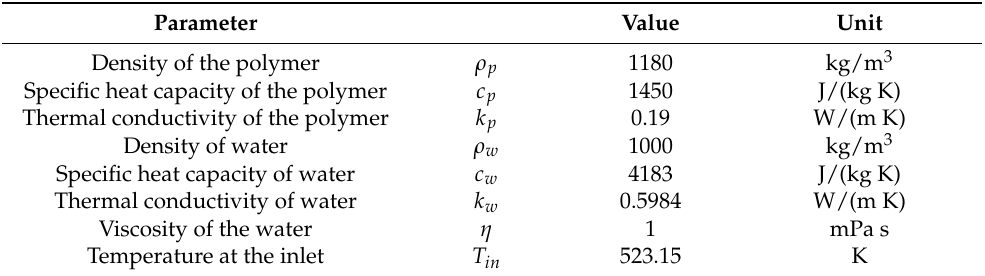
Table 2. Parameters used for the numerical simulation of the temperature profiles during cooling. Parameter Value Unit Density of the polymer ρ p 1180 kg/m 3 Specific heat capacity of the polymer c p 1450 J/(kg